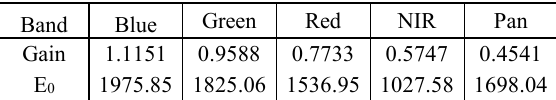
Table 2. Absolute gains for SSOT NAOMI - 1 (W/m 2 ·sr·μm) and exoatmospheric sun irradiance values (W/m 2 ·μm).